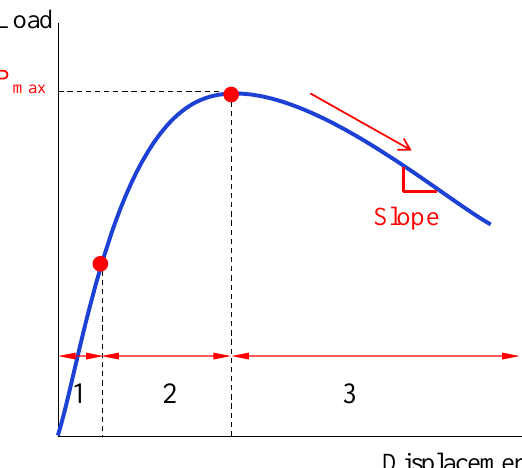
Figure 5. The simplified load-displacement curve for the DCB test.